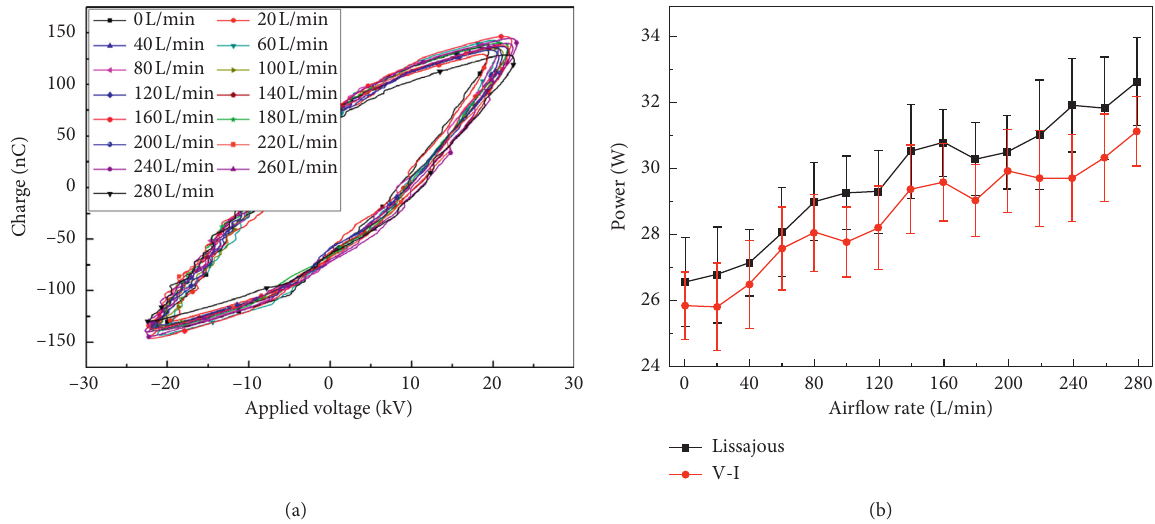
Figure 8: (a) Lissajous figures of the DBD-PACA under different airflow rate and (b) the trend of power calculated by Lissajous figure and current-voltage methods with airflow